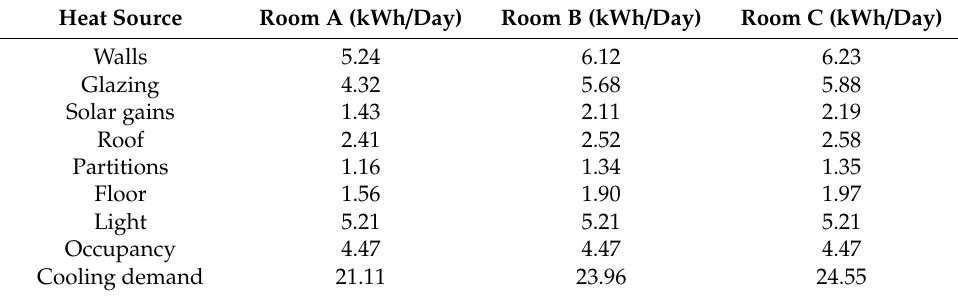
Table 4. Rooms values of internal heat loads for July